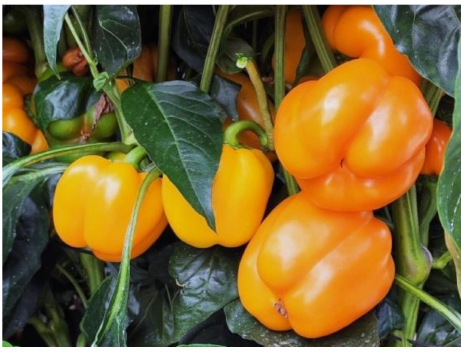
Figure 1. Capsicum annuum var. Kioto yellow pepper.